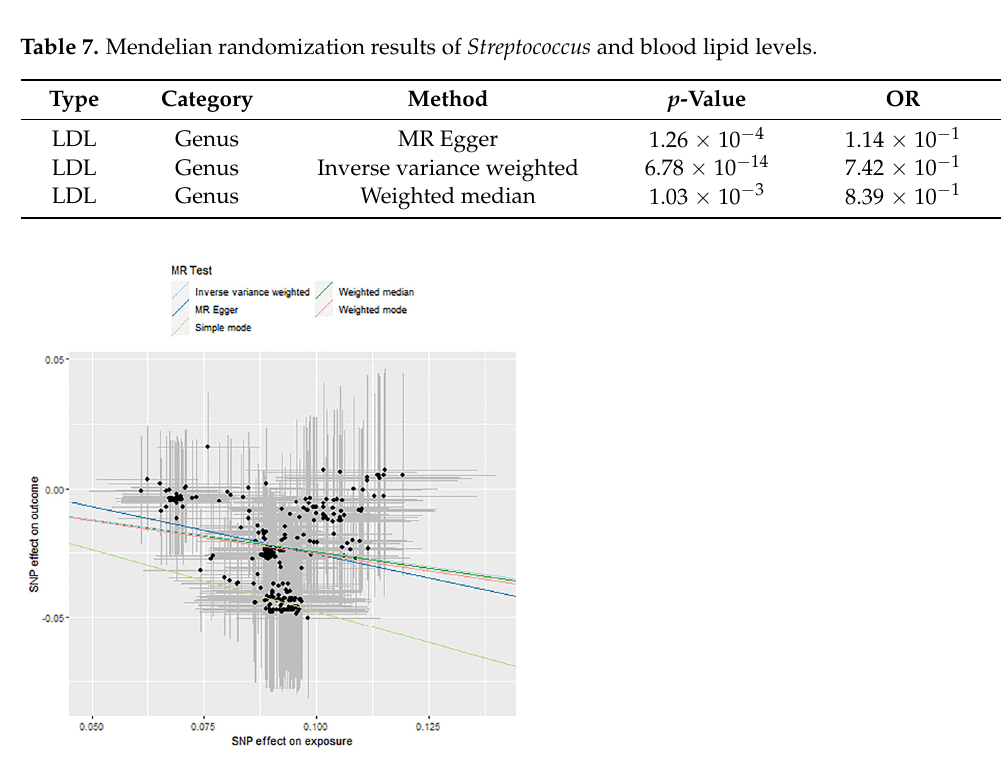
Figure 6. Causality analysis of Actinobacteria and blood lipid levels based on Mendelian randomization. The x -axis represents the effect value associated with SNP and Actinobacteria , and the y -axis represents the effect value associated with SNP and LDL and levels in the blood.